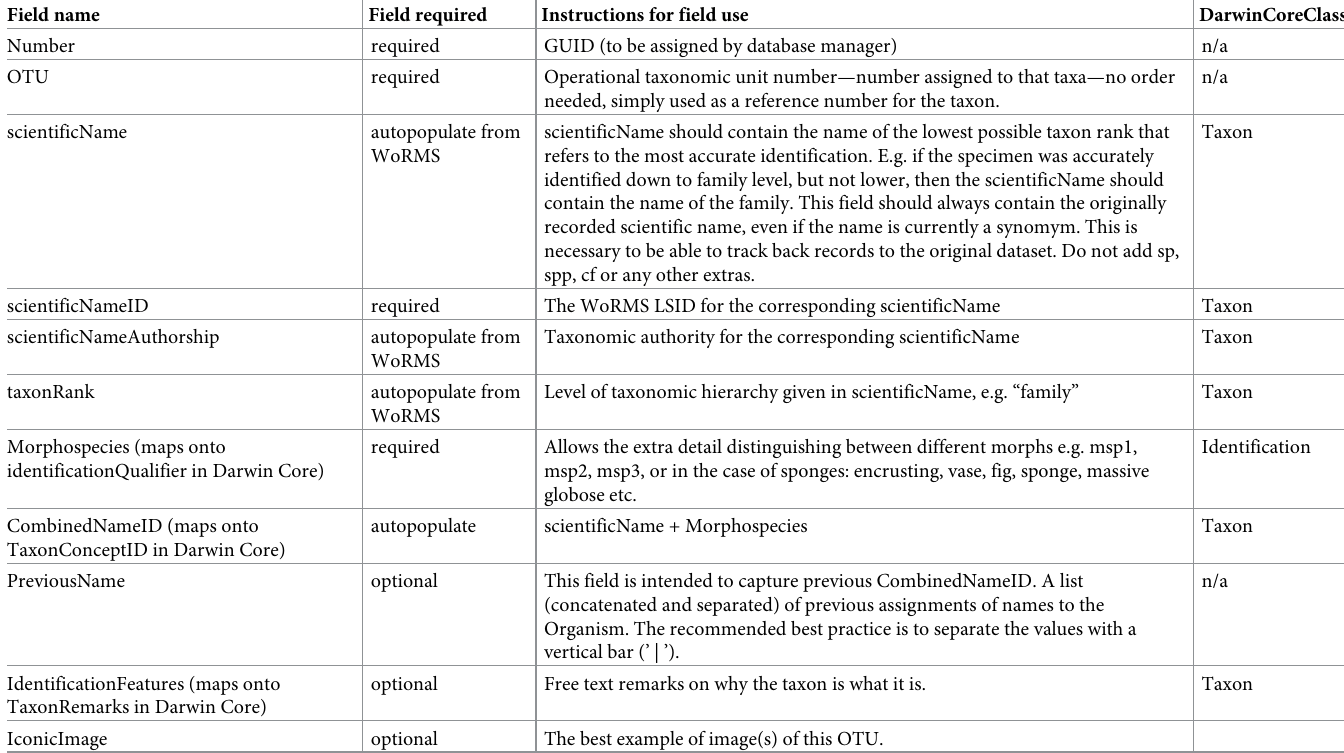
Table 2. The Operational Taxonomic Unit (OTU) table, one of two tables that make up the final